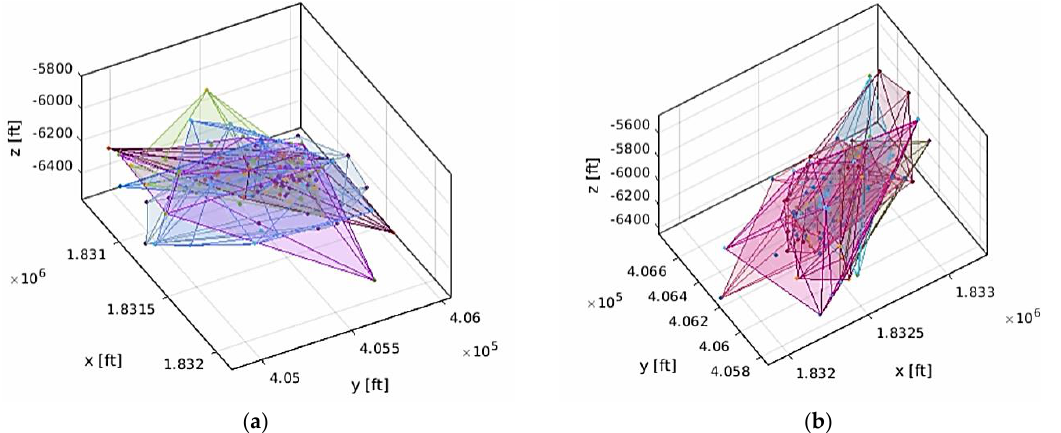
Figure 6. Example of the calculated SRV from MS events for two stages of MSEEL. ( a ) MIP-3H stage 7 ( b ) MIP-5H stage 12.